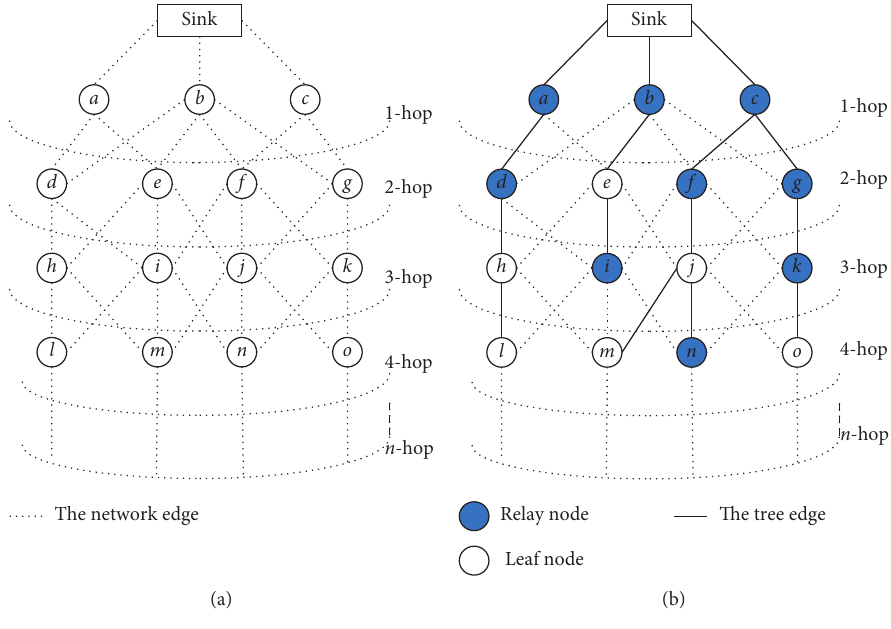
Figure 1: Tree data-transmitting topology structure